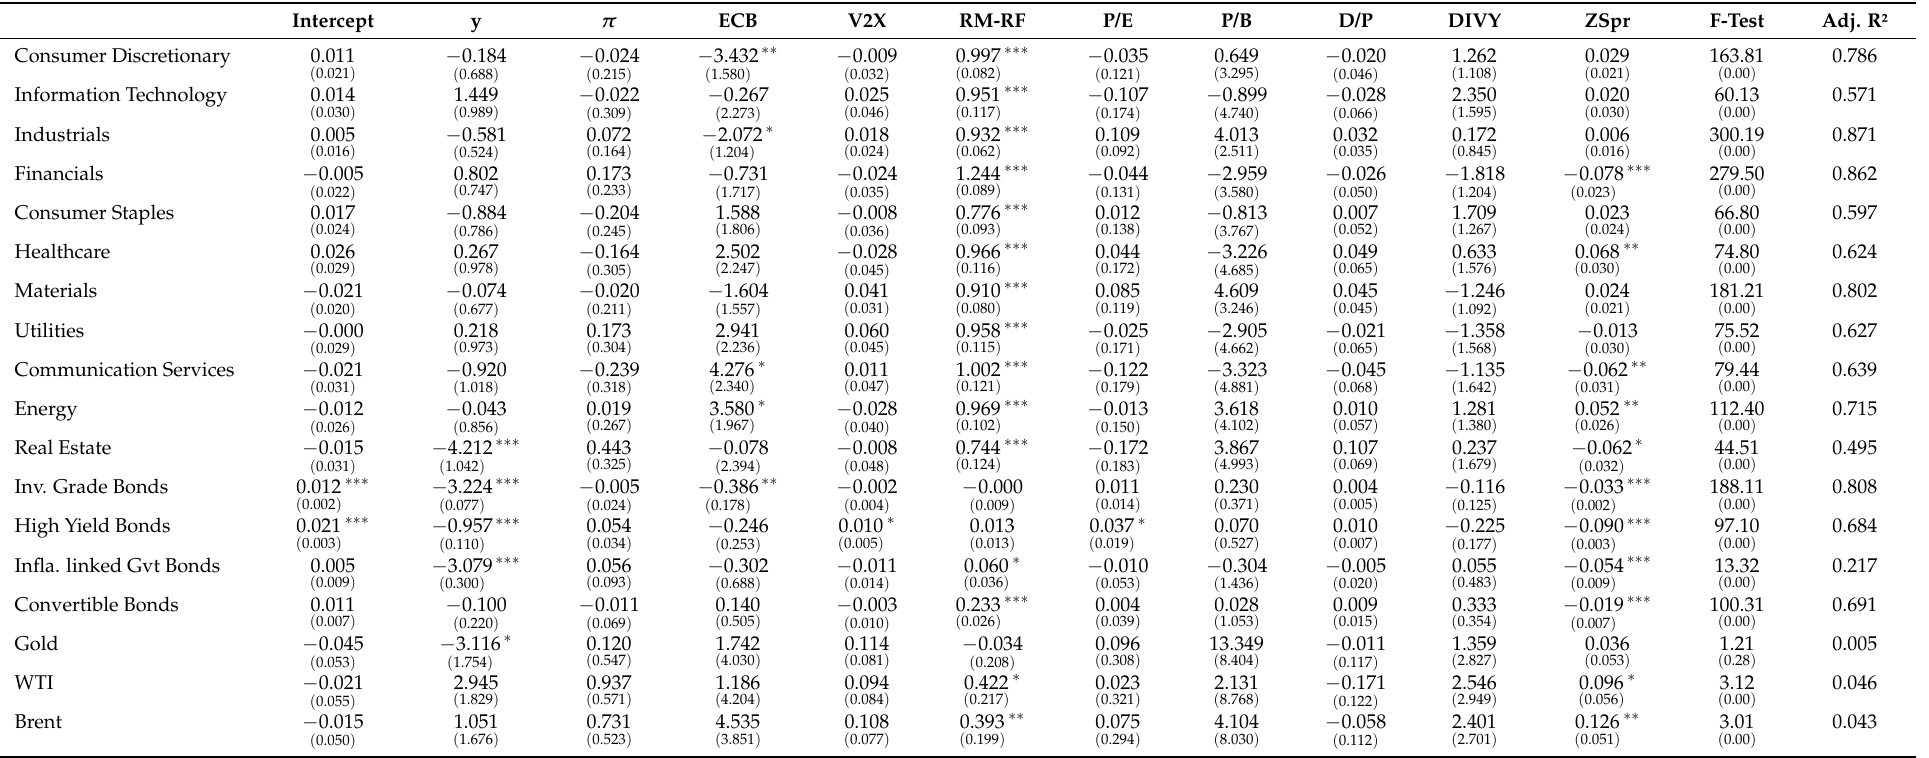
Table A1. Results of regressions conducted for our cross-asset panel for the low volatility regime of inflation expectations from 19 September 2012 to 12 August 2014. Error estimates are indicated in parentheses except for the F-Test, for which the p -value is in